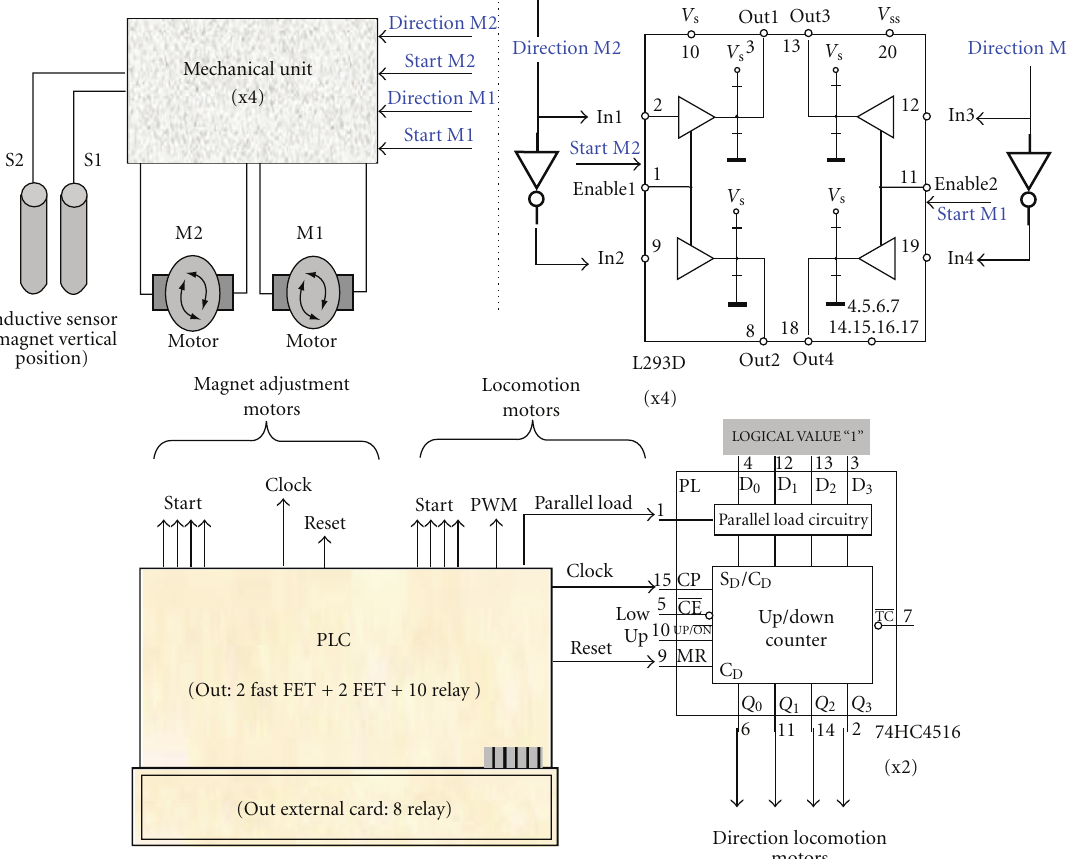
Figure 8: Schematic implementation of the climbing robot control